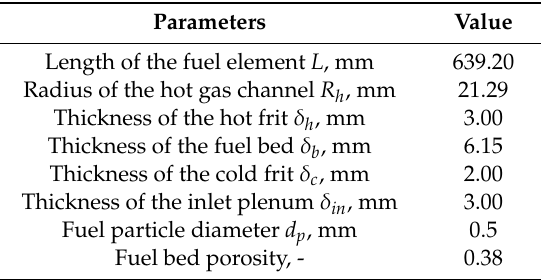
Table 5. Main geometrical parameters of the PBR.